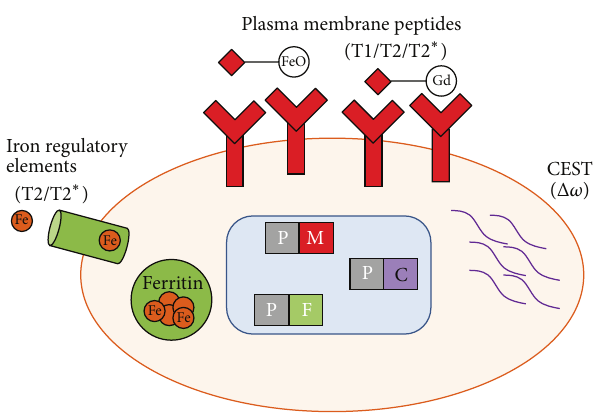
Figure 5: Schematic representation of MRI reporter genes used for cell labeling, reproduced with permission from reference [40].